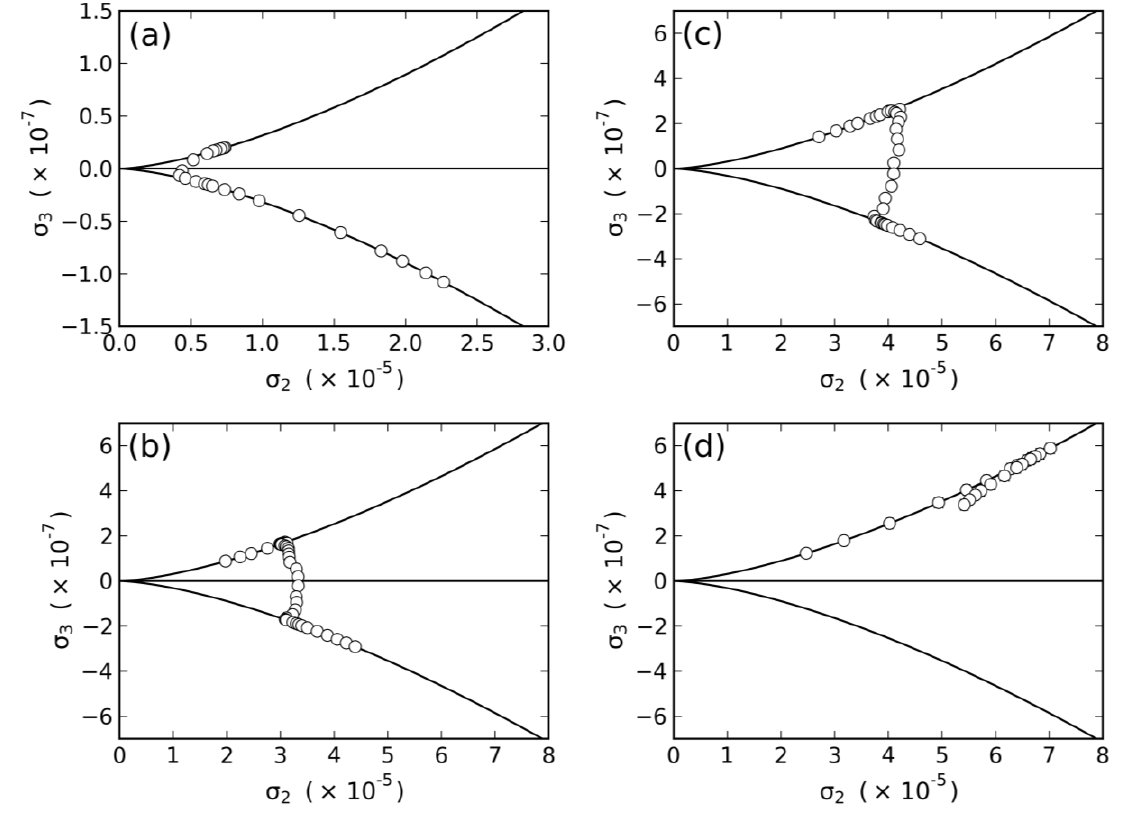
Figure 6. Typical X-ray diffraction patterns of the mixture DL -KDDS/Na 1-dodecanol/H